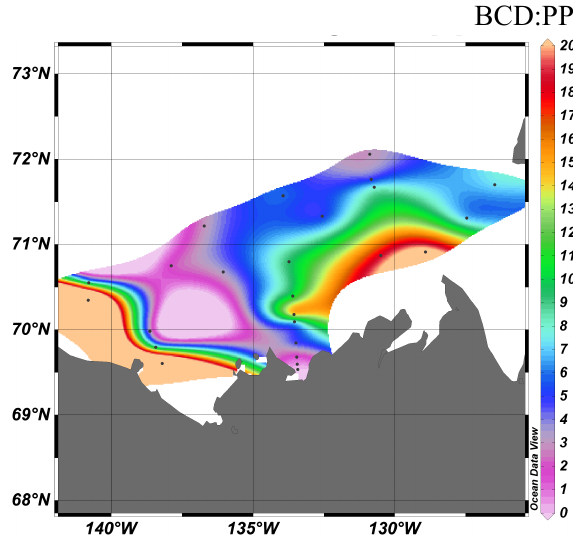
Fig. 4. Spatial pattern of bacterial carbon demand (BCD) to pri- mary production (PP) ratios using values integrated over the eu- photic layer. Values above 1 represent net heterotrophic